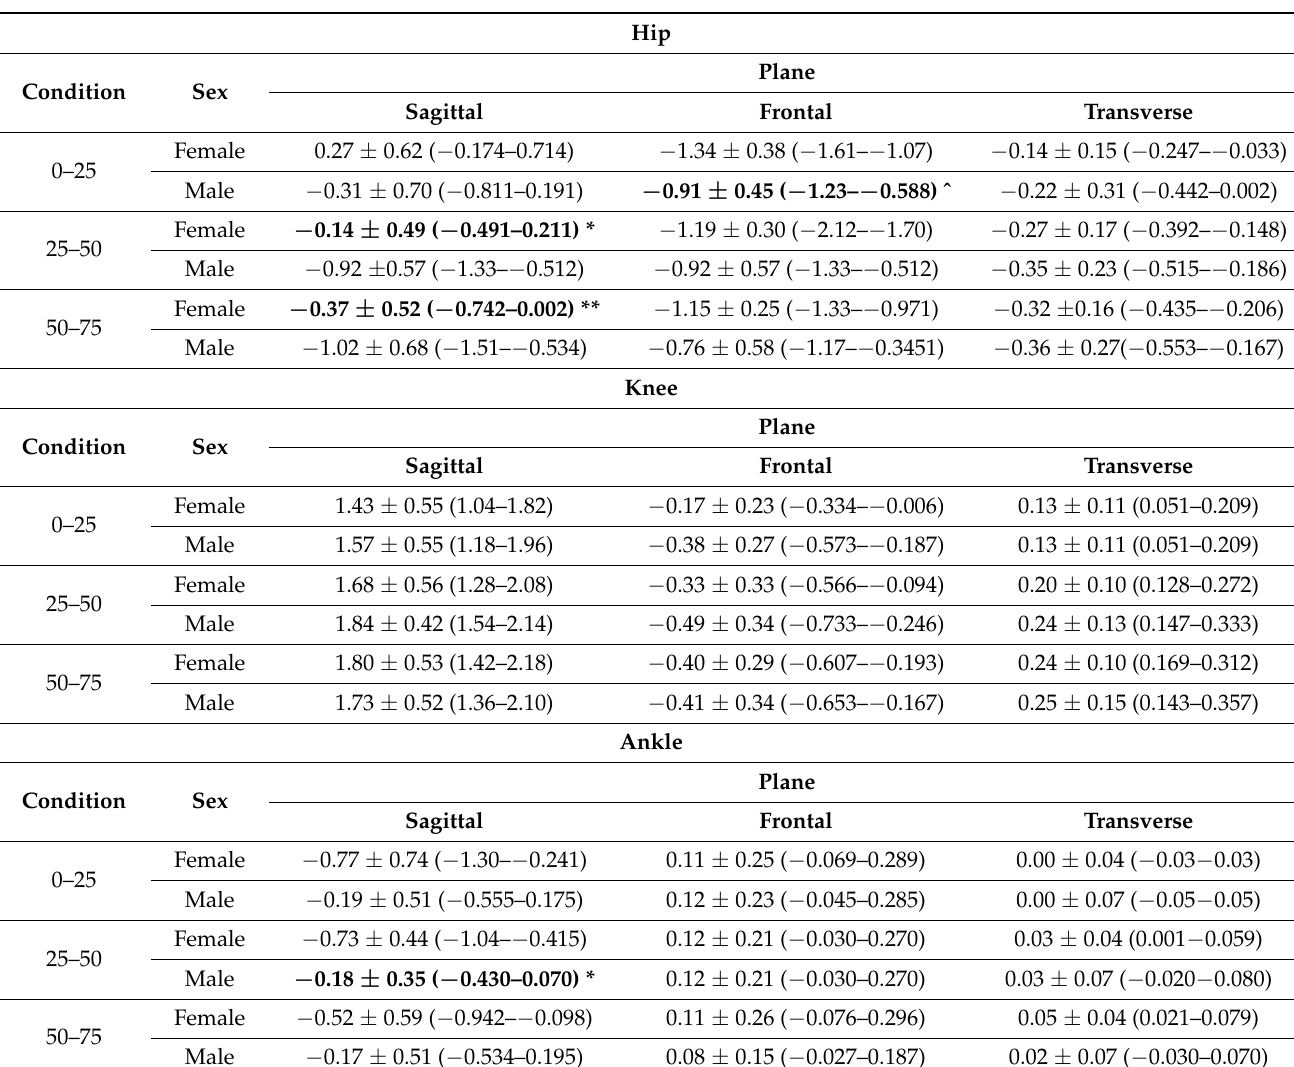
Table 4. Joint moments (sex comparison) 50